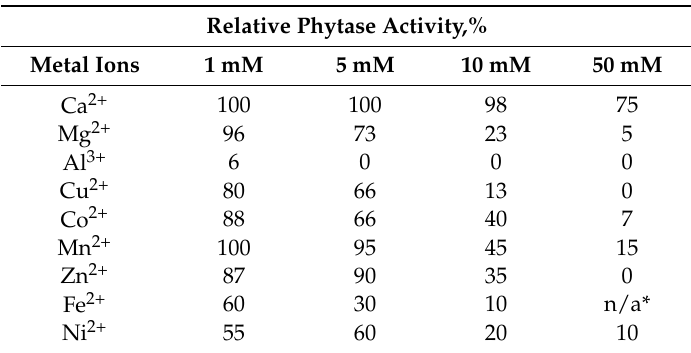
Table 2. Effects of metal ions on the relative phytase activity of